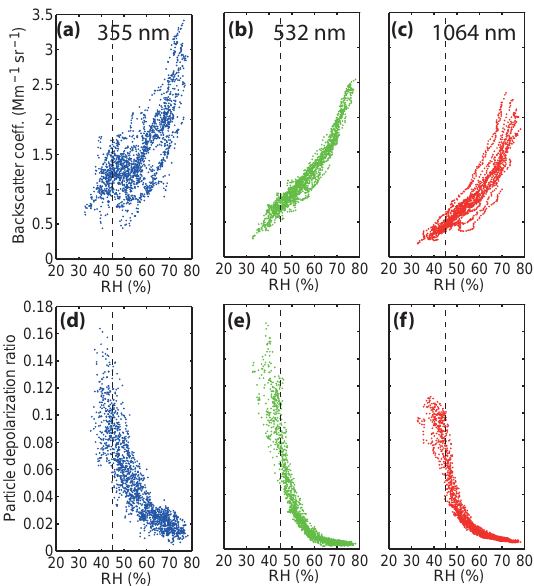
Figure 12. Correlation of the particle backscatter coefficient ( a–c ) and particle linear depolarization ratio ( d–f ) with RH for the three wavelengths 355, 532, and 1064nm. The BERTHA measurements of 23 February 2014, 23:38–01:08UTC, at 375–1100m height are used (5min temporal and 50m vertical resolution). The dashed line marks the sea salt efflorescence point (45% RH).